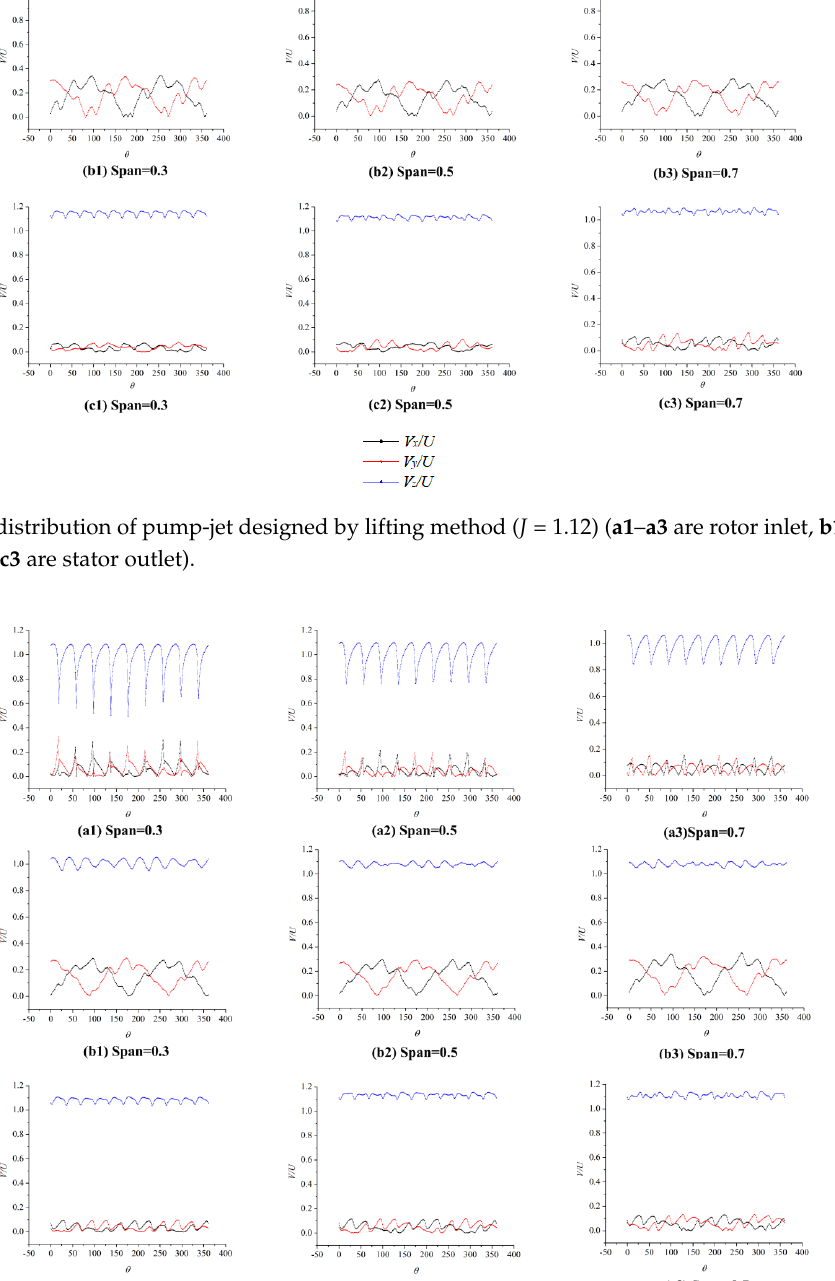
Figure 25. Comparison curves of pump-jet performance before and after optimization. After the optimization, the new pump-jet thruster performance has an evident im- provement. To make the improvement clearer to understand, we analyzed the pressure and velocity distribution characteristics. The chordal pressure distribution of the rotor and stator blades after optimization is shown in Figures 26 and 27. Compared to the optimized pressure coefficient distribution in the two figures, the basic pattern remains the same. From the curves of the pump-jet